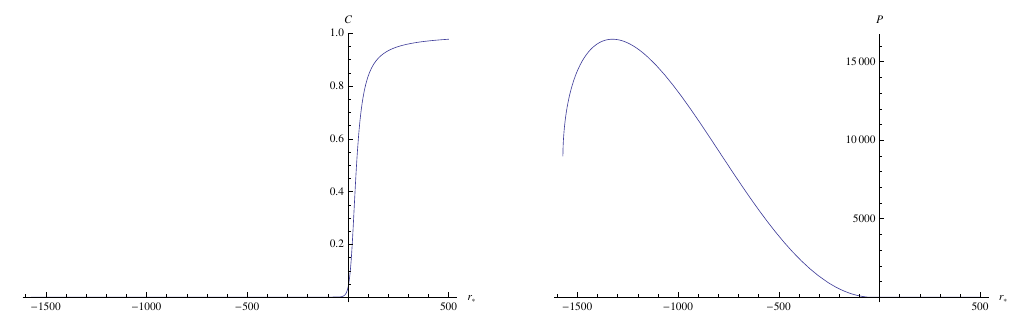
Figure 9 . The factor C and the pressure P for (cid:20)m 0 = 25 : 2, r (cid:3) s = (cid:0) 60 < a (cid:3) , a 0 = 10 and (cid:11) = 0 : 05. The factor C is always non-zero. The pressure P is (cid:12)nite everywhere. It vanishes at the outer surface of the star and is positive under the surface.